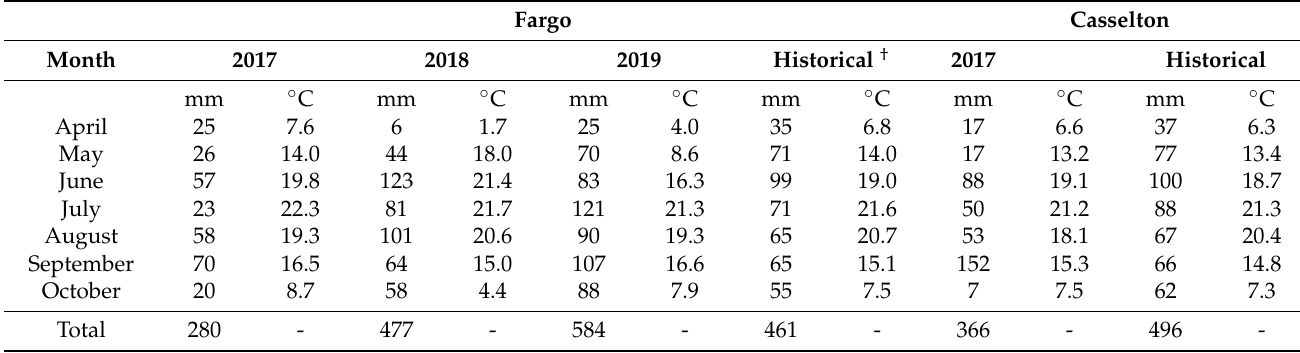
Table 4. Monthly total precipitation, average air temperature, and historical data at Fargo and Casselton, ND, 2017, 2018, and